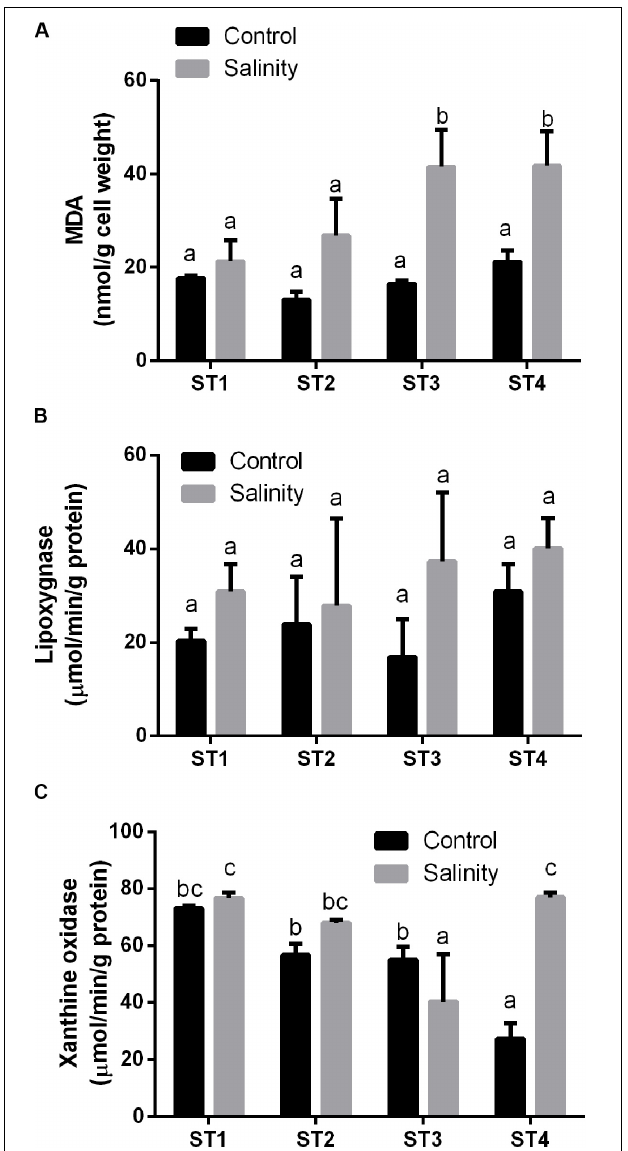
FIGURE 3 | The oxidative damage markers of four salt-tolerant bacterial isolates (ST1, ST2, ST3, and ST4) in terms of (A) lipid peroxidation (MDA), (B) lipoxygenase activity, and (C) xanthine oxidase activity under control and salinity stress conditions. Data are represented by the mean of at least three replicates, and error bars represent the standard error. Different small letters (a, b, c ... ) above bars indicate significant differences between means at p < 0.05.